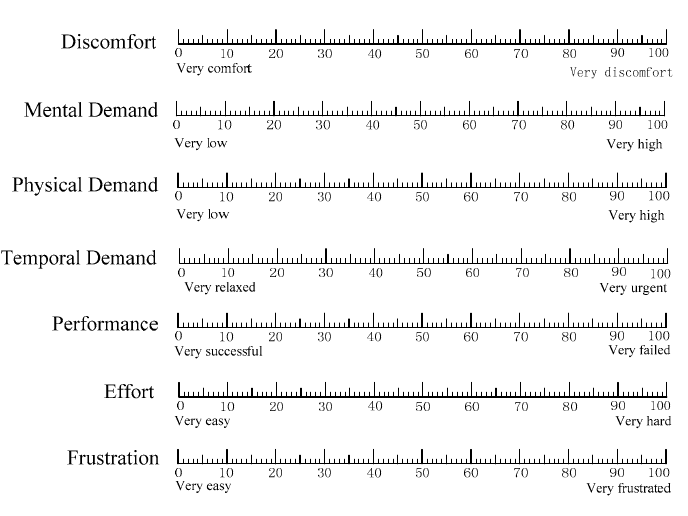
Figure 4. The extended NASA-TLX rating scales [19].